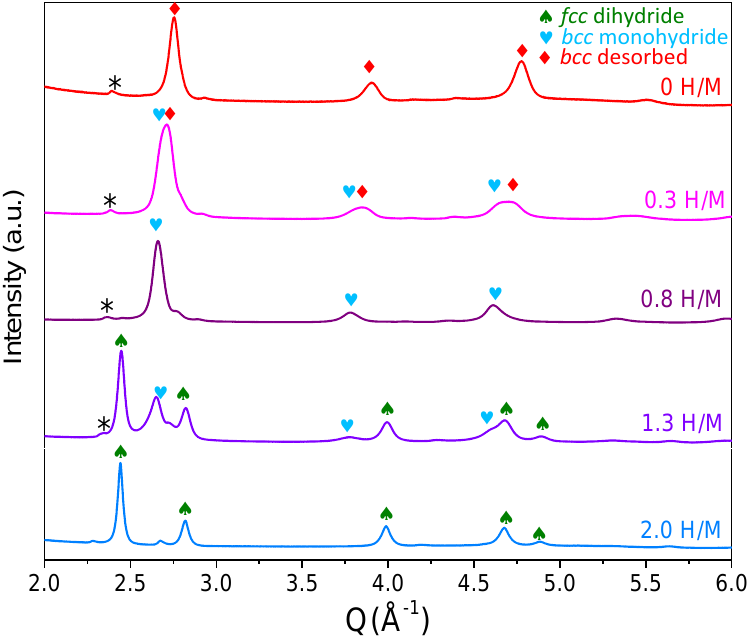
Figure 5. Ex situ SR-XRD patterns of Ti 0.30 V 0.25 Cr 0.10 Zr 0.10 Nb 0.25 at different stages of the dehydrogenation process with the following capacities: 2.0 H/M, 1.3 H/M, 0.8 H/M, 0.3 H/M, and 0 H/M. Minor impurity is marked with star symbol. The fcc dihydride, bcc monohydride and bcc desorbed phases are marked with green spades, blue hearts and red diamonds, respectively.